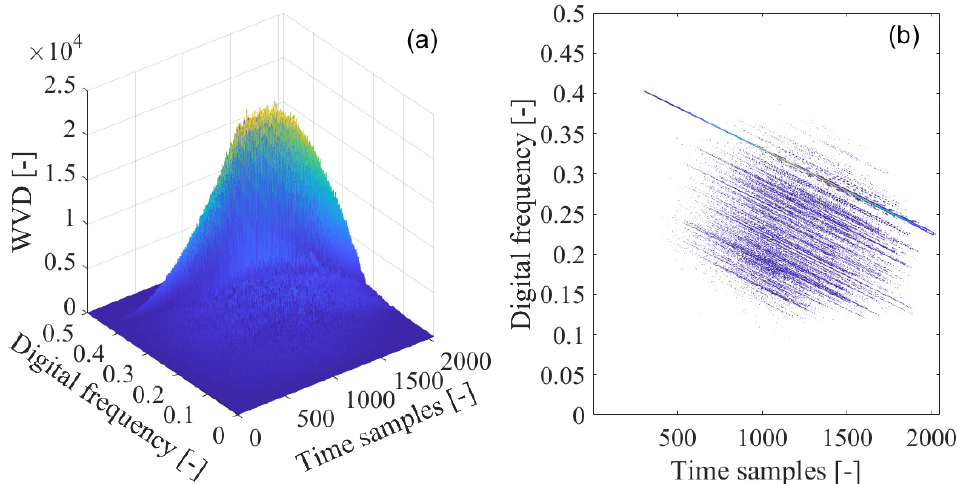
Figure 10. The Wigner–Ville distribution (WVD) of the GPS L1-C/A signal disturbed by the sweep interference; ( a ) WVD; ( b ) WVD’s contour.